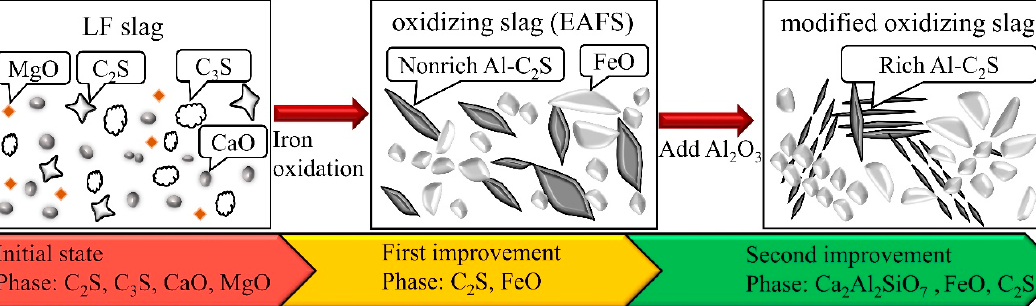
Figure 8. Schematic diagram showing the phase transition from LFS to modified oxidizing slag in the dephosphorization process and the crystalline phases of each stage.